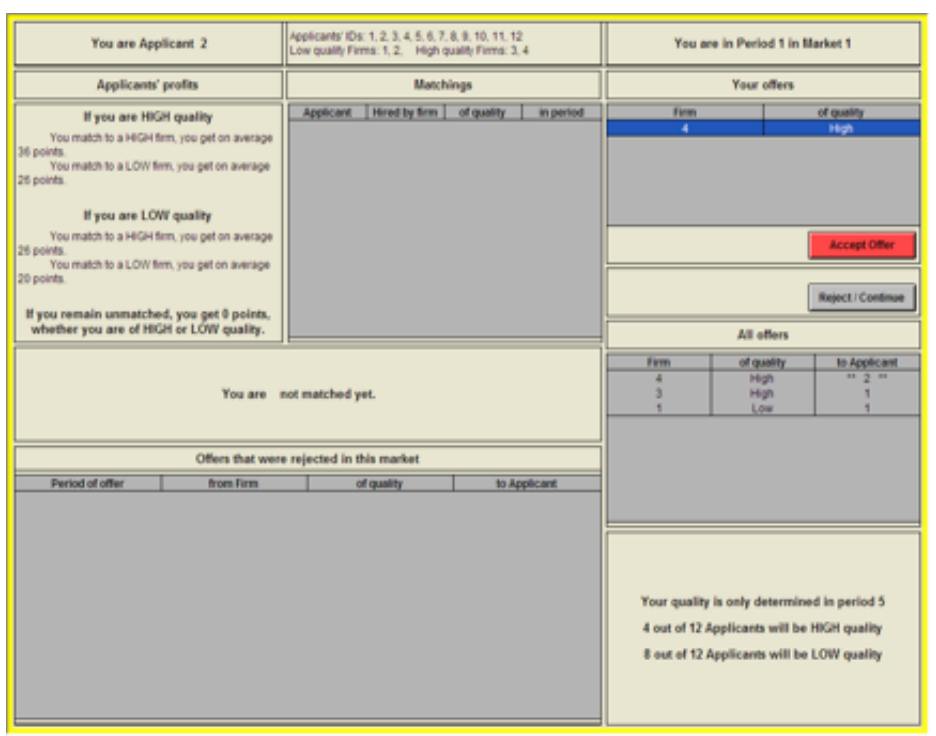
Figure 7. Applicant Screen, Periods